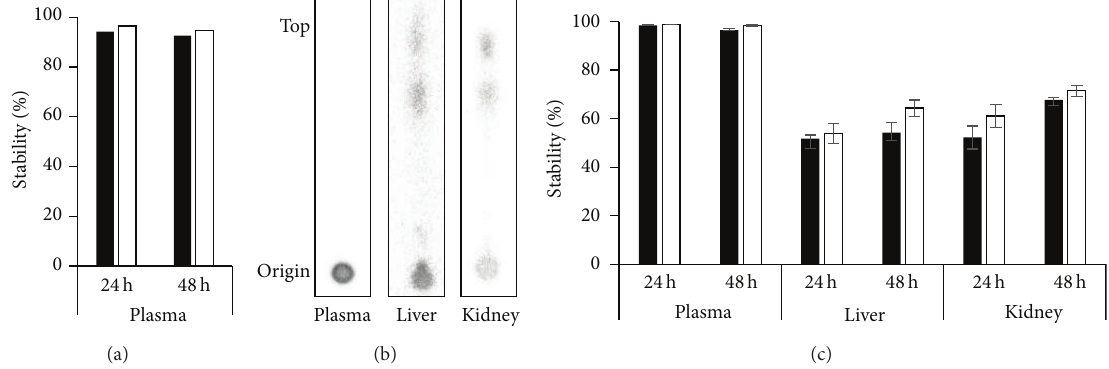
Figure 5: In vitro and in vivo stability of 64 Cu-DOTA-11-25 mAb and 64 DOTA-anti-KLH mAb. (a) In vitro stability of 64 Cu-DOTA-11-25 mAb (black bars) and 64 DOTA-anti-KLH mAb (white bars) after 24 hours and 48 hours of incubation at 37 ∘ C. Radioactivity derived from antibody- bound 64 Cu stays at the origin and unbound 64 Cu goes to the top of the chromatogram. The percentage of radioactivity that remained in the origin of TLC was shown as the stability. (b) Representative TLC-ARG of plasma and supernatant of homogenate from liver and kidney 24 hours after injection of 64 Cu-DOTA-11-25 mAb. Aliquot of blood, liver, and kidney was taken from mice 24 hours after injection and analyzed by TLC-ARG as described in Section 2. (c) In vivo stability of 64 Cu-DOTA-11-25 mAb (black bars) and 64 Cu-DOTA-anti-KLH mAb (white bars) 24 and 48 hours after